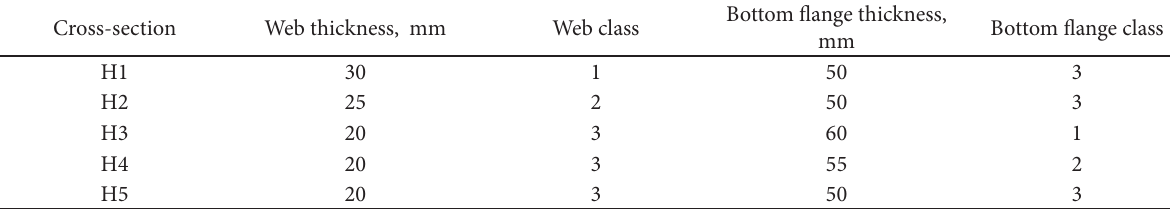
Table 3. Cross-sections under investigation on hogging zone – class 3 Cross-section